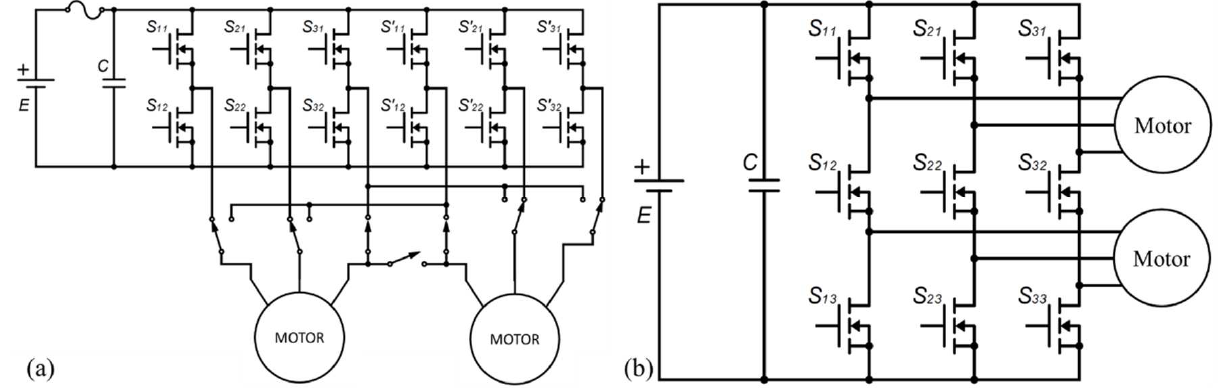
Figure 7. ( a ) six-leg inverter reconfiguration into a five-leg inverter [46], ( b ) Shared arm topology for dual-motor systems [3].